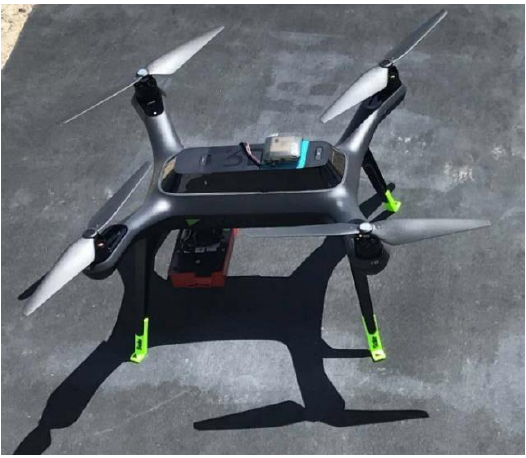
Figure 1. 3D Robotics 8X+ octocopter equipped with MicaSense Red Edge ™ 3 Multispectral